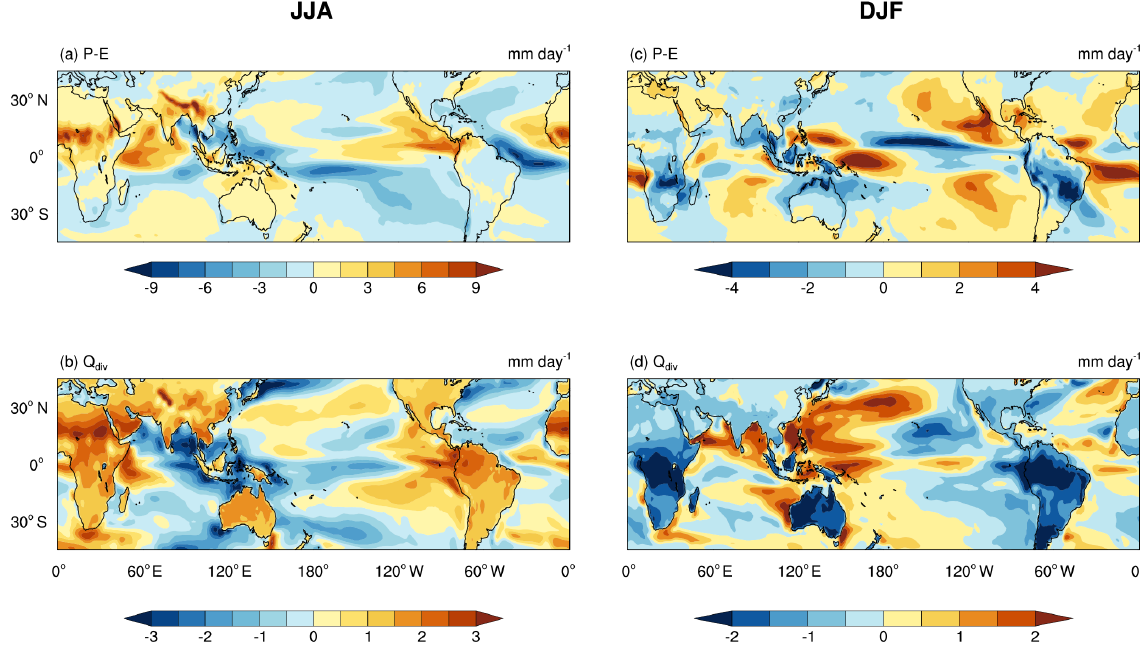
Figure 5. The difference in P − E (a, c) and Q div (b, d) . (a) and (b) are for the JJA mean and (c) and (d) are for the DJF mean.